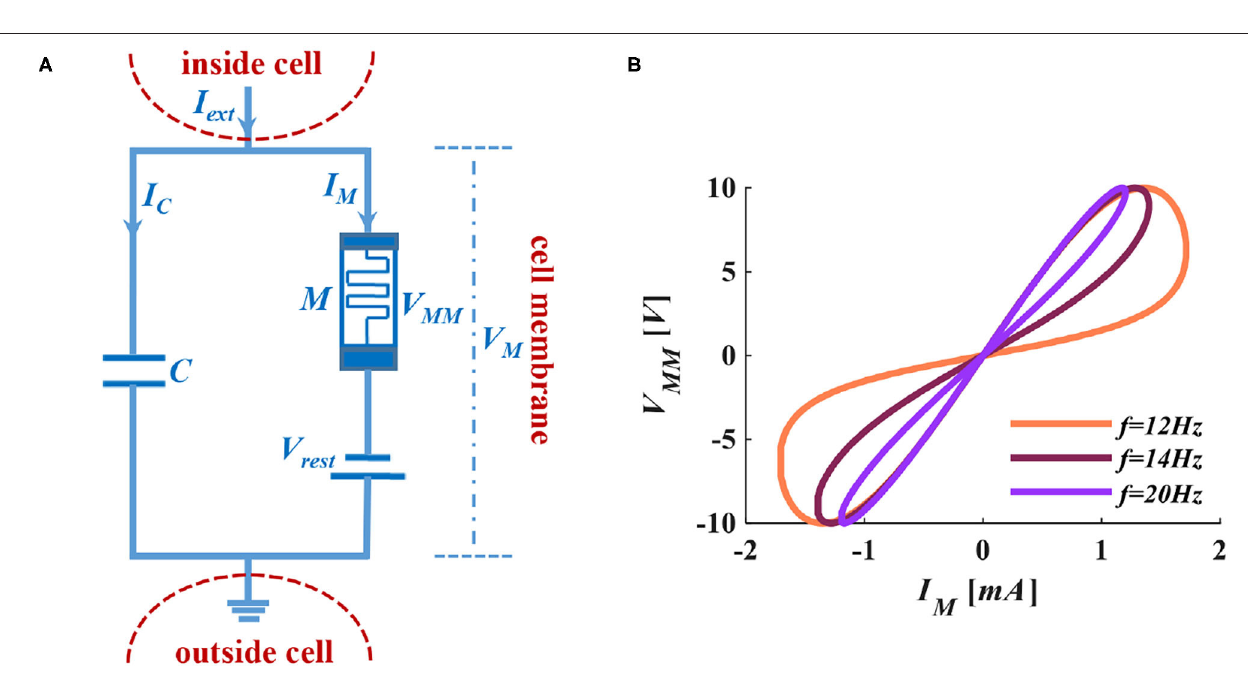
FIGURE 2 | The MLIF circuit model and the I-V curve of the memristor. (A) MC membrane circuit of the MLIF model. (B) The pinched hysteresis curve and frequency characteristics of ion channel memristor.